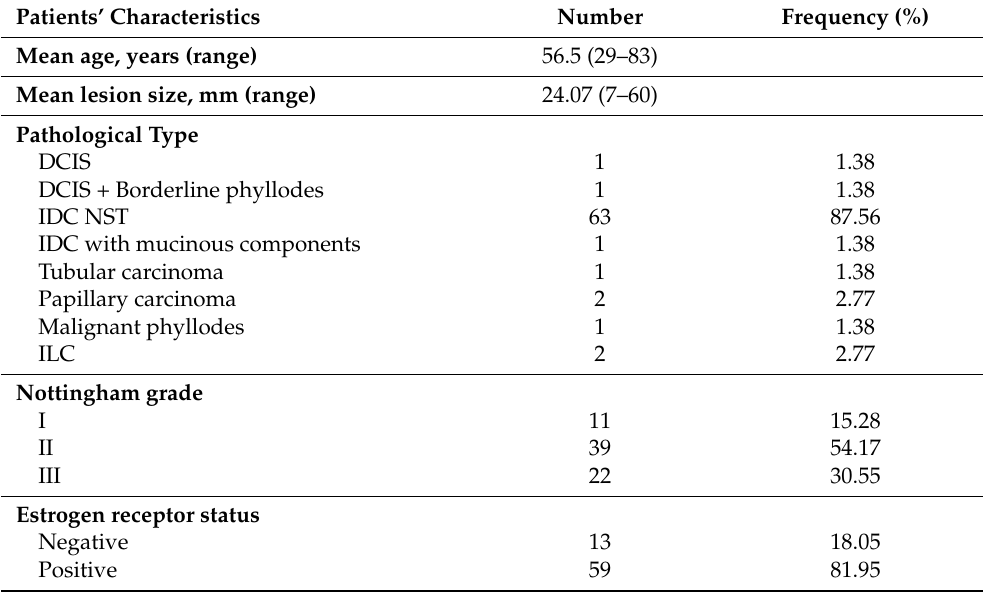
Table 2. Patients’